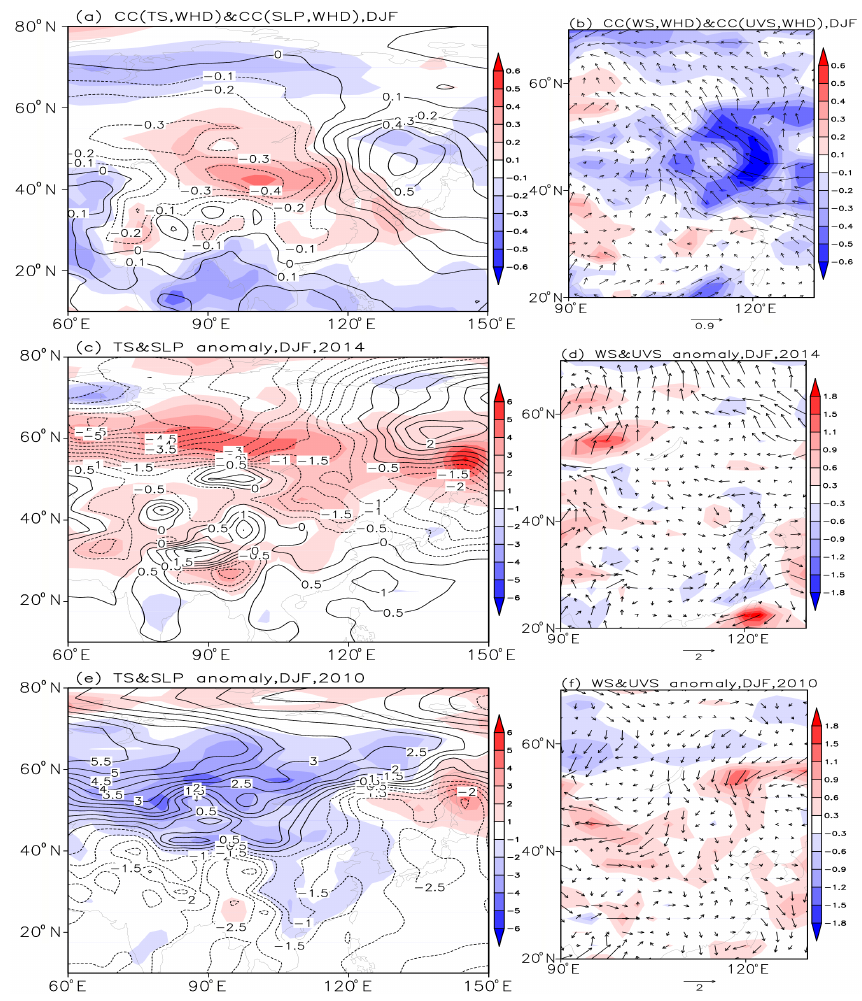
Figure 5. Correlation coefficients between WHD NCP and winter circulations from 1979 to 2012 with the linear trend removed (a, b) , as well as circulation anomalies in 2014 (c, d) and 2010 (e, f) . The circulations in panels (a, c, e) are T s (shade) and SLP (contour), and those in panels (c, d, f) are surface wind speed (shade) and wind vector